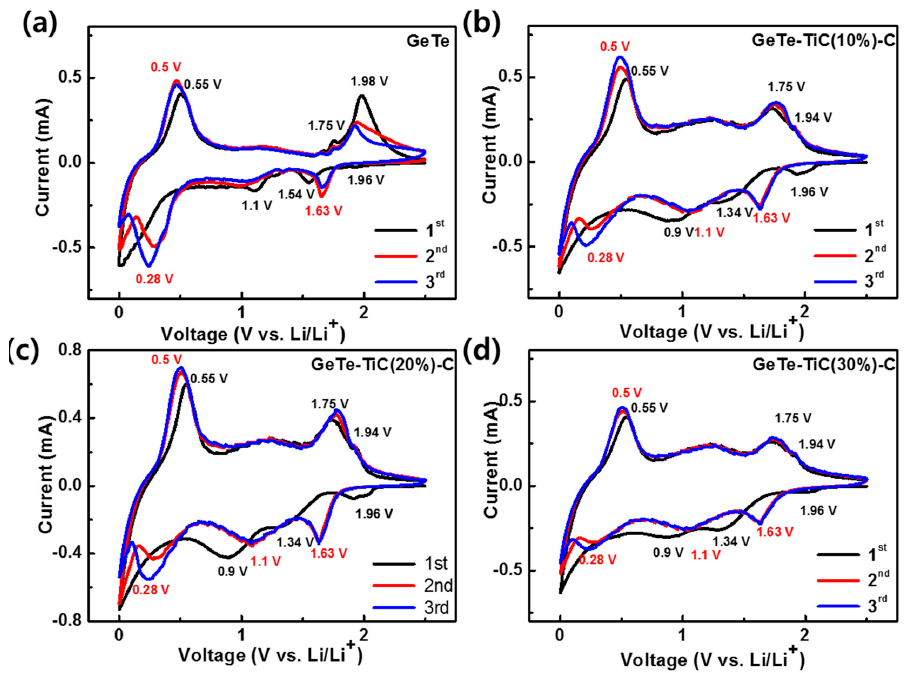
Figure 5. Cyclic voltammograms of ( a ) GeTe, ( b ) GeTe-TiC (10%)-C, ( c ) GeTe-TiC (20%)-C, and ( d ) GeTe-TiC (30%)-C in the three initial cycles at 0.1 mV s − 1 .